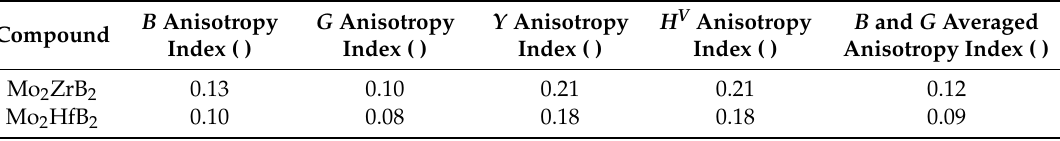
Table 3. Anisotropy of the bulk, shear and Young’s modulus as well as the Vickers hardness of Mo 2 ZrB 2 and Mo 2 HfB